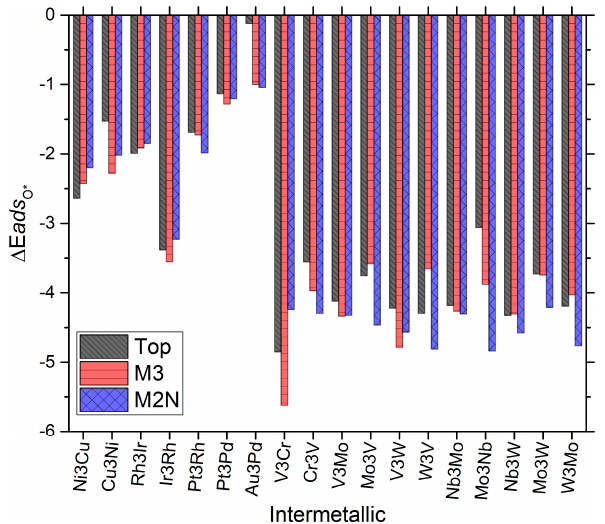
Figure 2. Plot of energy bandwidths for adsorption of monoatomic oxygen (O*) on the candidate systems studied in this work for 4 atom MDG NP. Various site types are presented in each set of the columns. Energies given are in units of eV/mol. The formalism/reference state for calculating the energy is given in Equation (1).